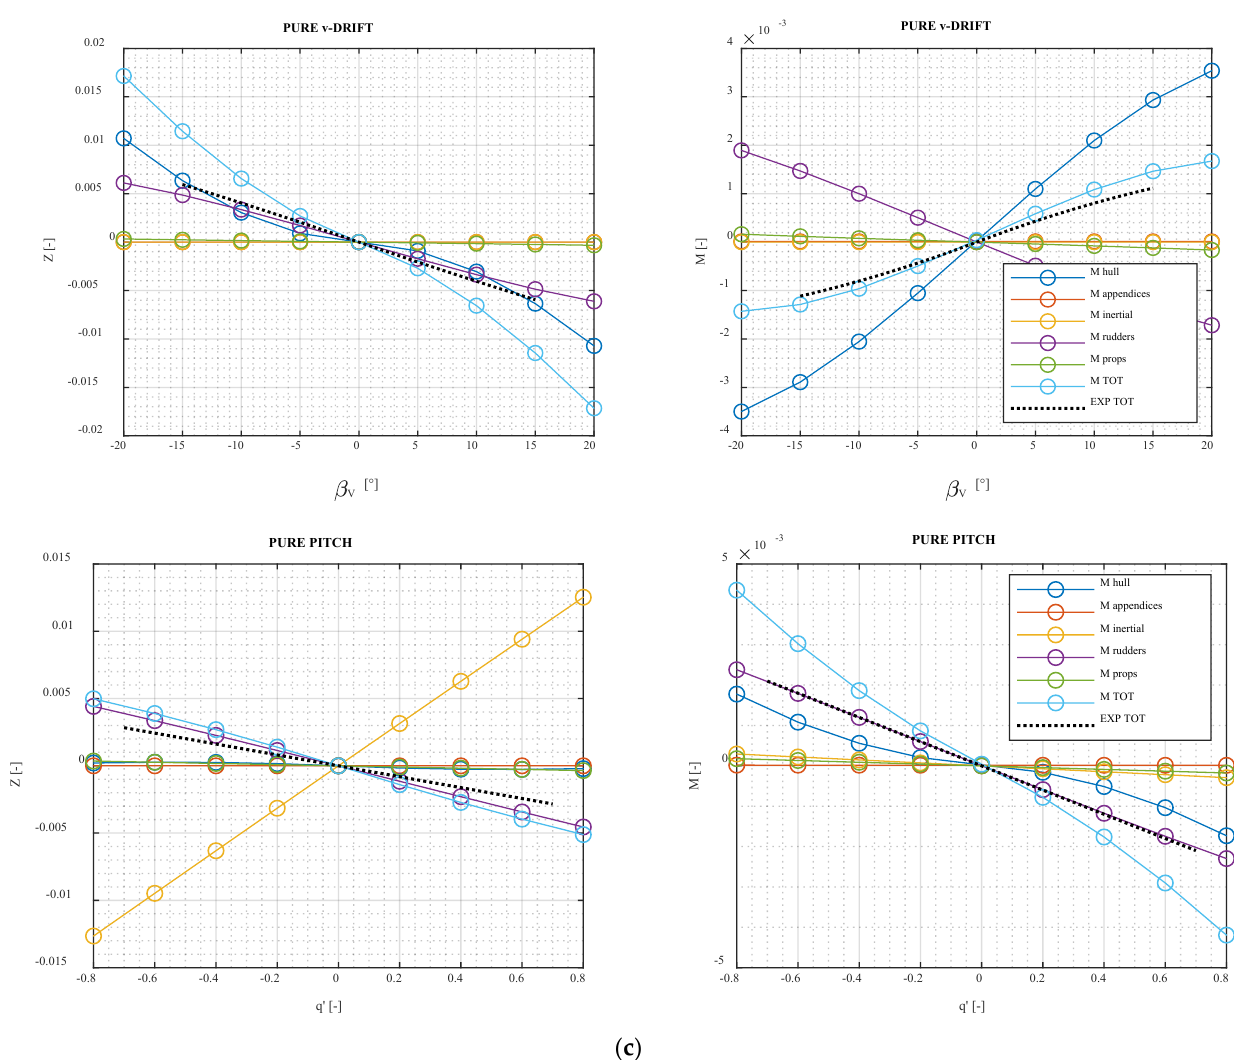
Figure 11. ( a ) SWE captive model testing validation—horizontal plane. ( b ) SWE captive model testing validation—horizontal plane roll. ( c ) SWE captive model testing validation—vertical plane.